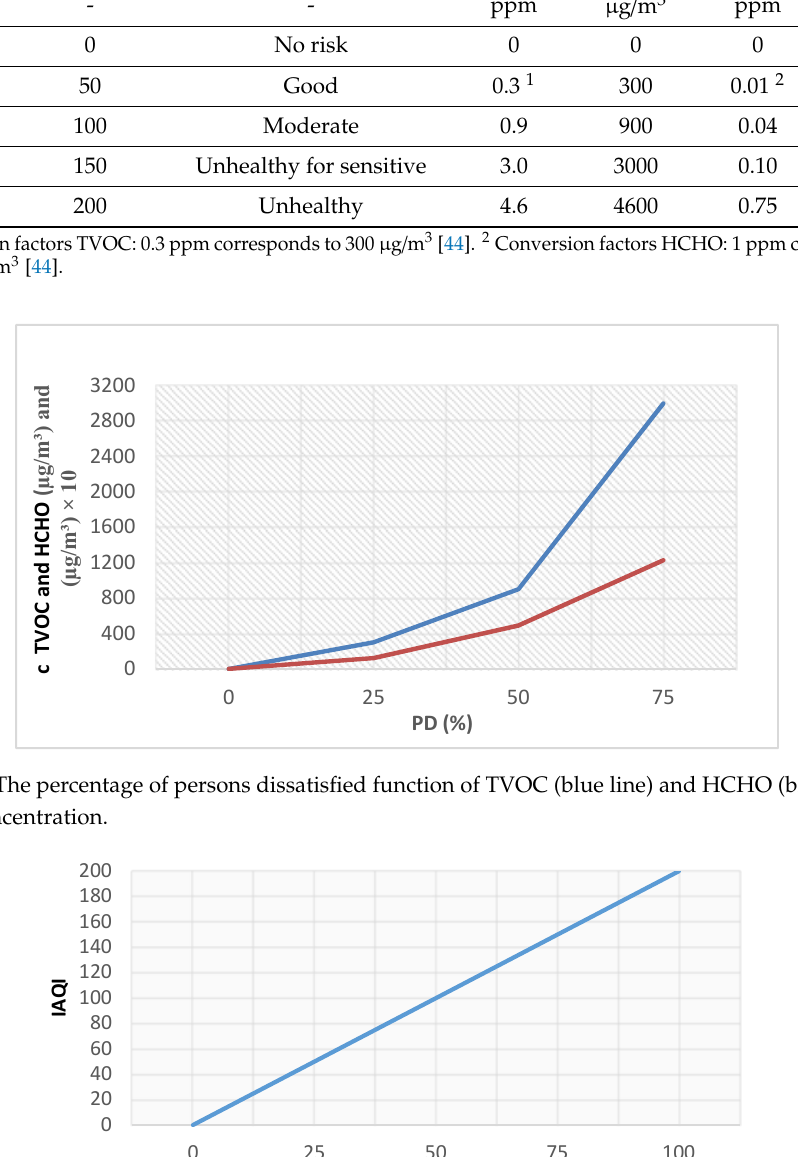
Table 7. Recalculation and conversion of IAQI value scales.